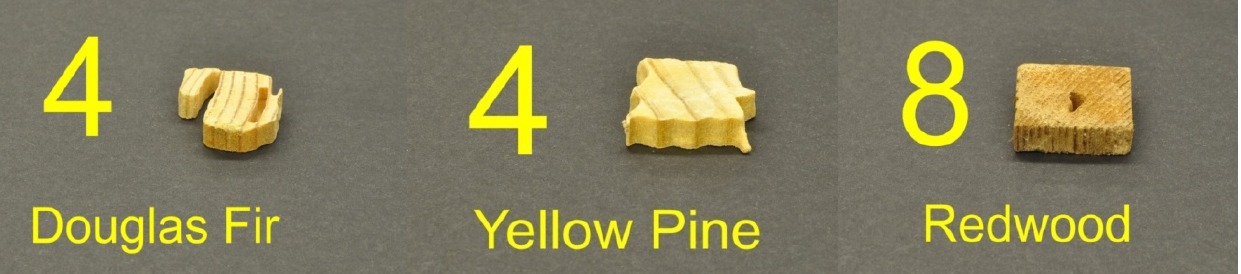
Figure 5. Sample visual ratings for C. formosanus EI Rating (modified from E1-09): 4 = very severe, 50–75% affected; 8 = moderate, 3–10% affected.